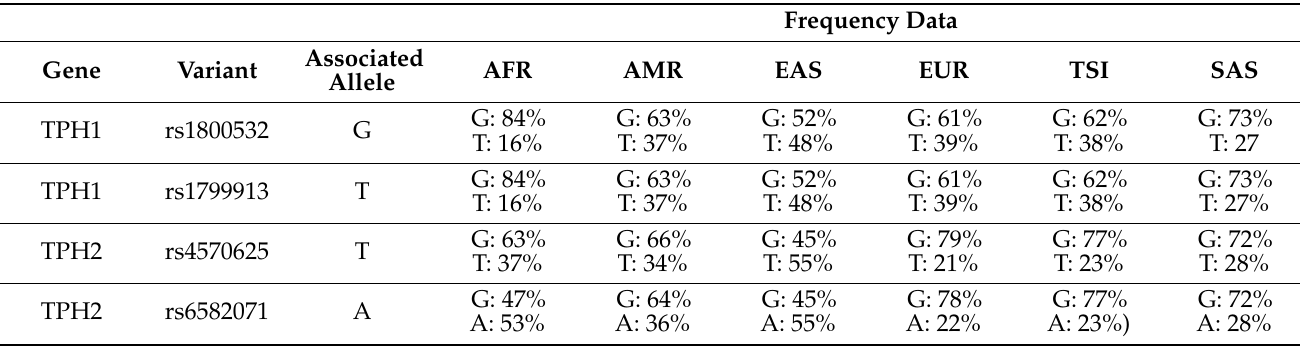
Table 1. Polymorphisms details. Abbreviations: African (AFR), American (AMR), East Asian (EAS), European (EUR), Toscani in Italy (TSI) and South Asian (SAS), not considered (n.c.) [13–15,18].